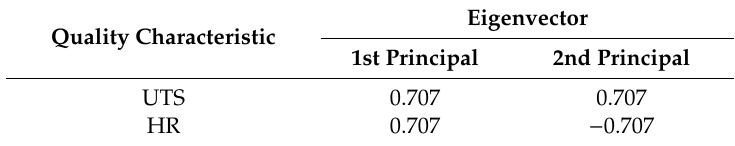
Table 13. The Eigenvectors for the principal component of ultimate tensile strength and hardness.